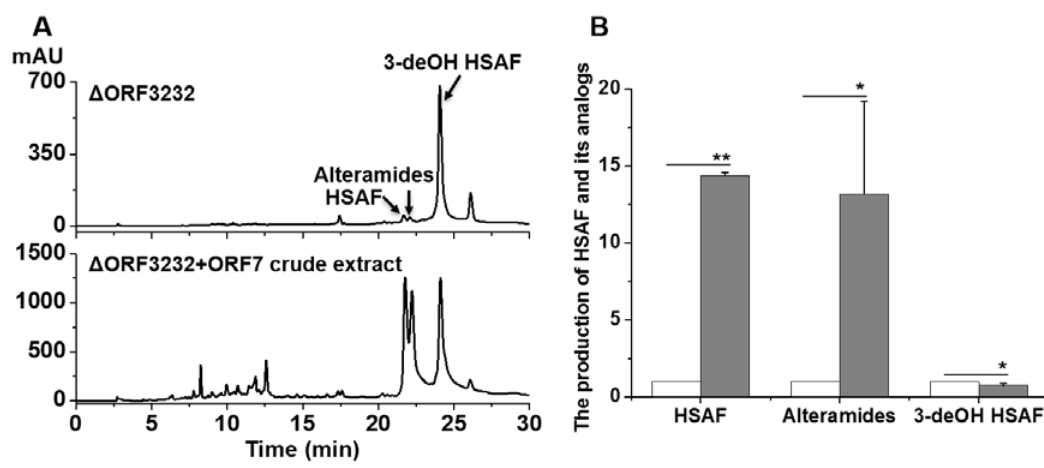
Figure 4. Bioconversion of 3-deOH compounds to HSAF and alteramides. ( A ) HPLC analysis of HSAF and its analogs in the LeTetR mutant, ∆ ORF3232, with or without addition of an enzyme extract from the E. coli -expressing hsaf-orf7 . ∆ ORF3232 was cultured in 1 / 10 TSB medium for 72 h. ( B ) Quantification of HSAF and its analogs in the cultures. Note: As the 3-deOH alteramides were minor compounds and not well-resolved from 3-deOH HSAF in HPLC, only 3-deOH HSAF was presented in the quantification. White columns, ∆ ORF3232 without the enzyme extract; gray columns, ∆ ORF3232 with the enzyme extract. Data are presented as averages of three independent experiments, each conducted in triplicates, with * p < 0.05; ** p < 0.01.